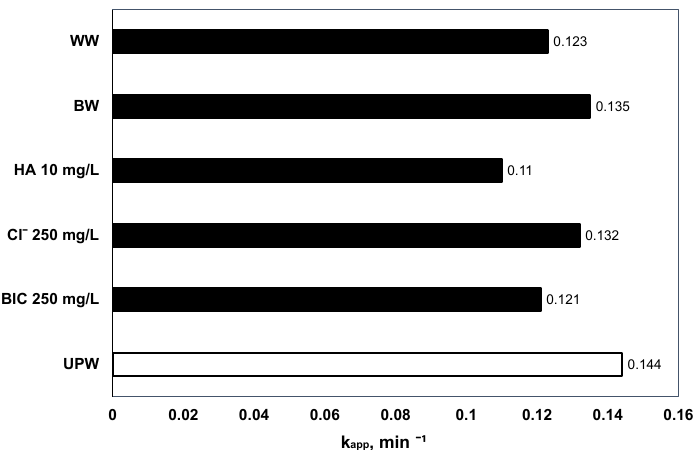
Figure 7. Effect of water matrix on the degradation of SMX in the combined 3D process. Conditions: [SMX]° = 500 μ g/L, [BCS_650] = 2 g/L, [Na 2 SO 4 ] = 0.1 M, j = 8 mA/cm 2 .